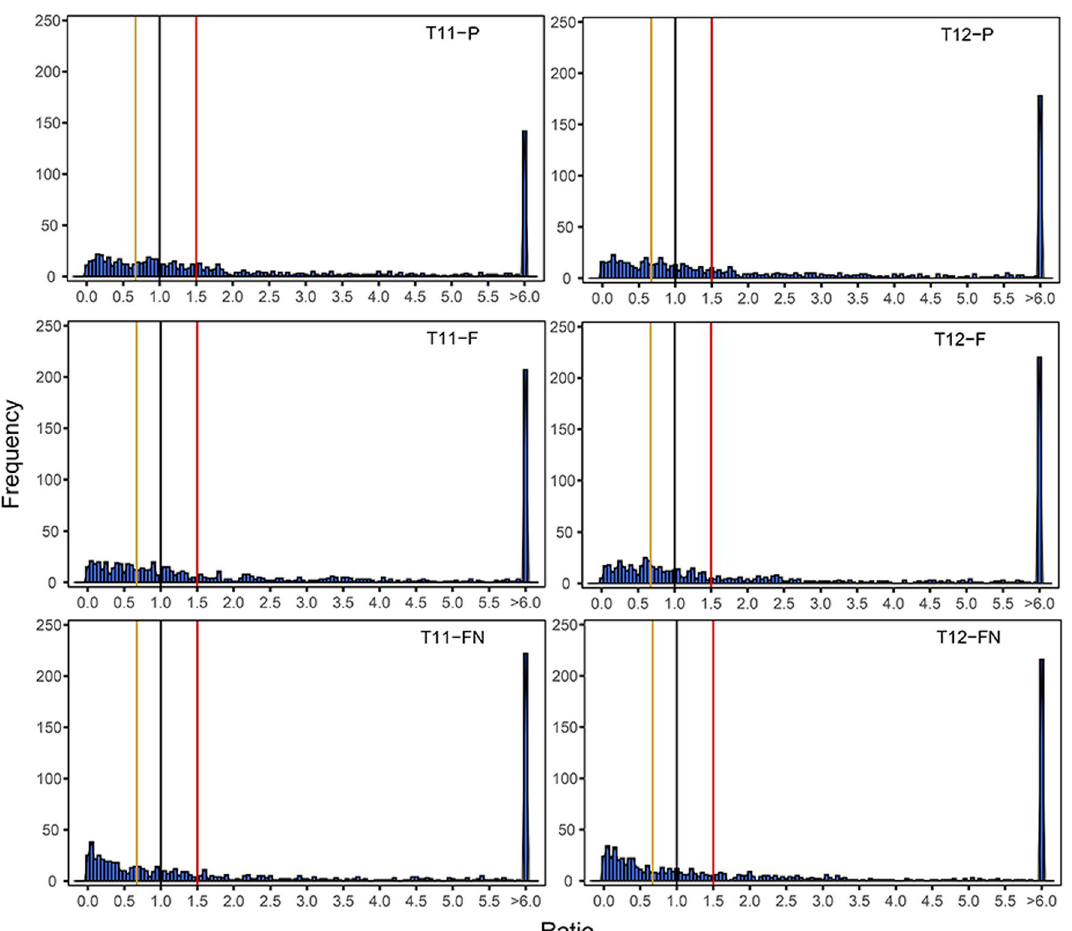
Fig. 5 Ratio distributions of gene expression of the functional class of stress-related genes in T11 and T12. The ratios were plotted with bins of 0.05 increments. X-axis represents the ratio bin of fold-change in gene expression levels and Y-axis represents the gene frequency per